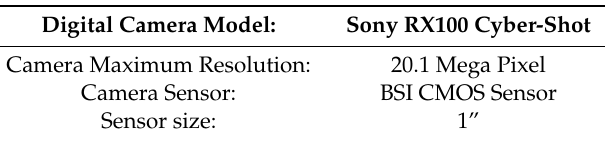
Table 3. Characteristics of Used Camera